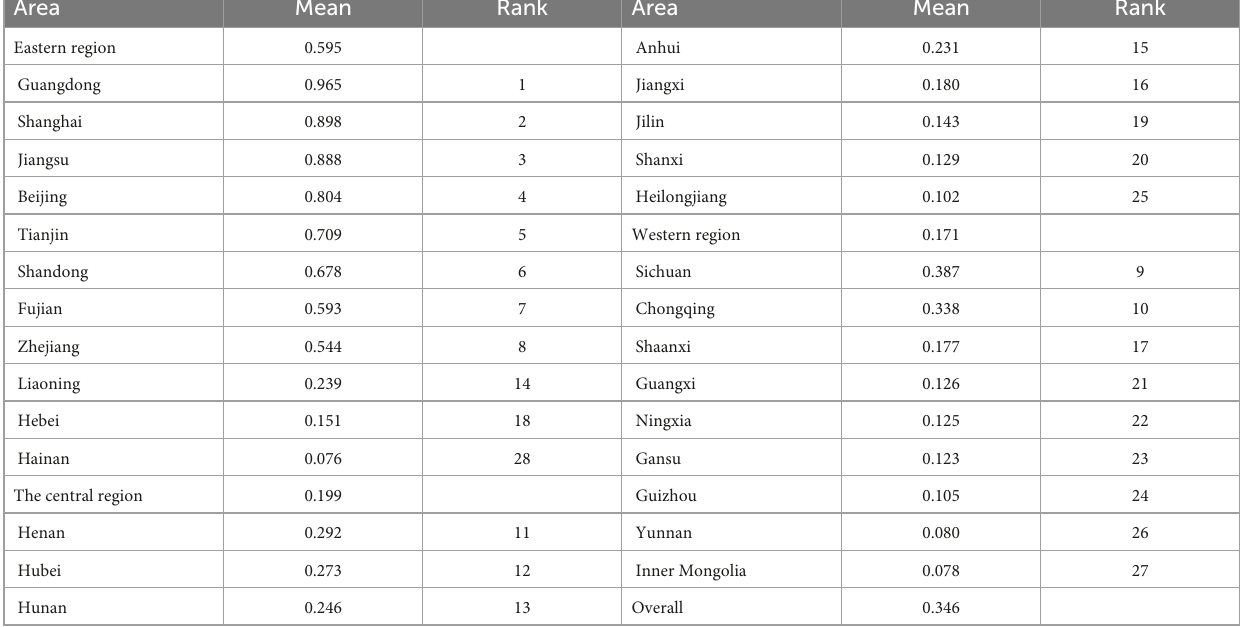
TABLE 8 Environmental efficiency of China’s HTM.